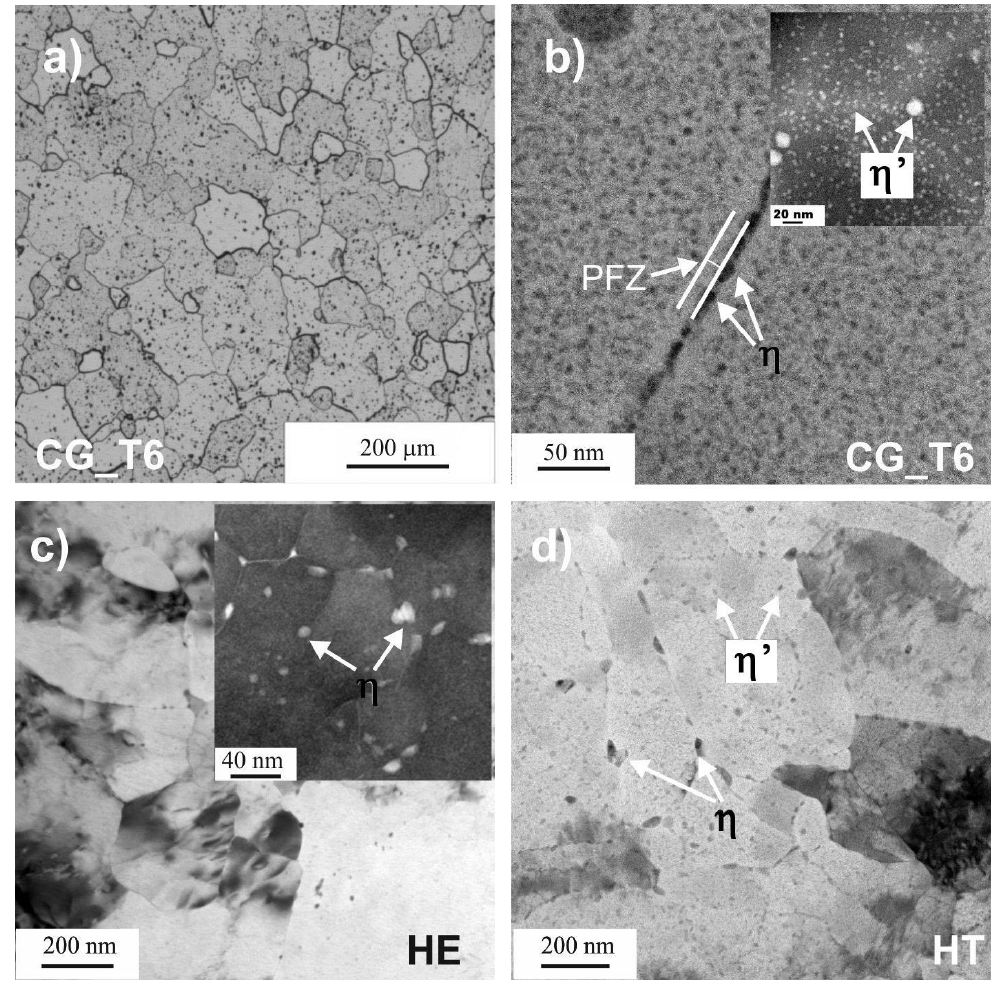
Figure 1. Microstructure of the 7475 Al alloy: ( a ) SEM microstructure of the CG_T6 sample, ( b ) TEM microstructure of the CG_T6 sample, ( c ) TEM microstructure of the HE sample, ( d ) TEM microstruc- ture of the HT sample.